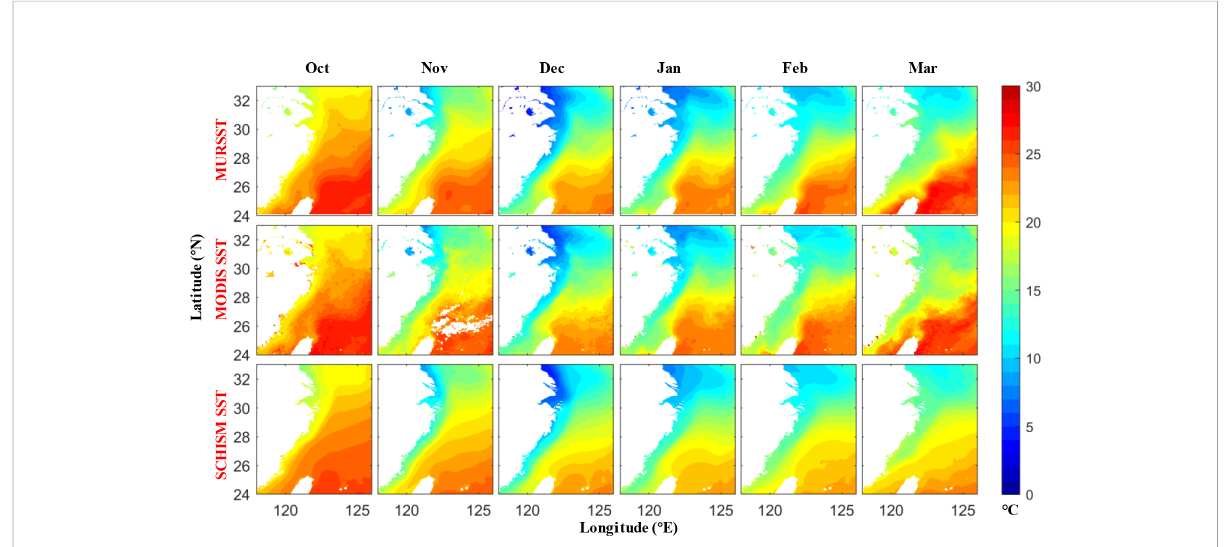
FIGURE 6 Comparison of monthly averaged SST between simulated and satellite-observed (MURSST and MODIS-Aqua) SST from October 2020 to March